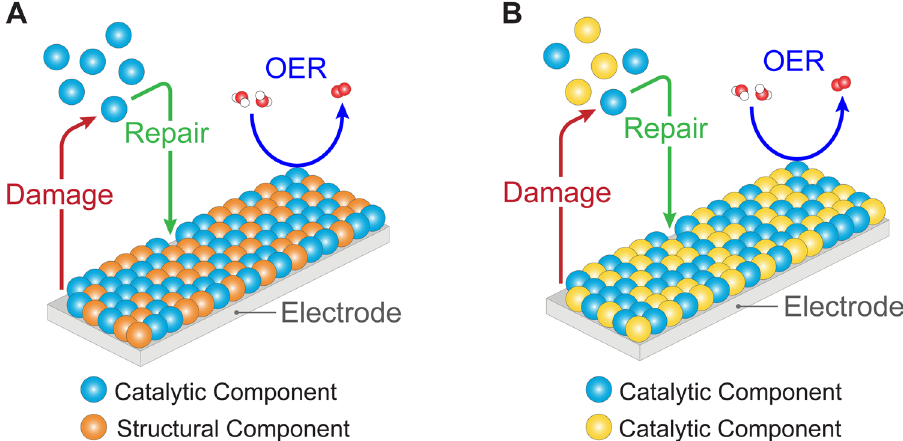
Fig. 6 Schematic depiction of two common types of mixed-metal oxide OECs (M ′ M – OECs) that may possess self-healing properties. A Self-healing M ′ M – OEC system composed of separate catalytic (e.g., Co, Ni; blue spheres) and structural components (e.g., PbO x ; orange spheres). B Self-healing M ′ M – OEC system comprising two types of catalytic components (blue, yellow spheres). Self-healing in both types of systems involves the catalytic component(s) undergoing damage and repair while performing OER. The colored spheres above the electrode surface denote dissolved catalyst capable of